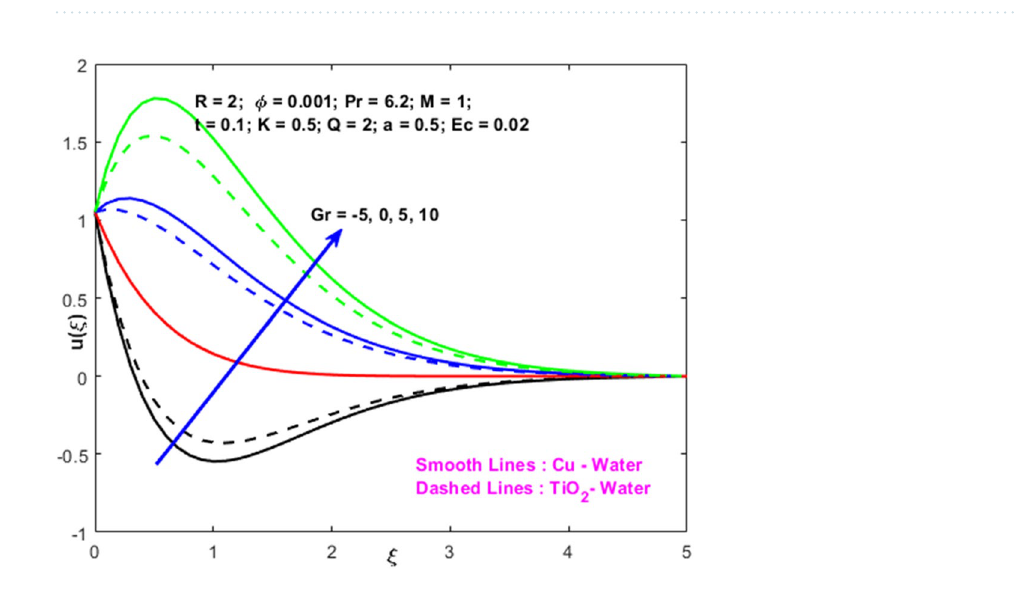
Figure 6. K v/s u .